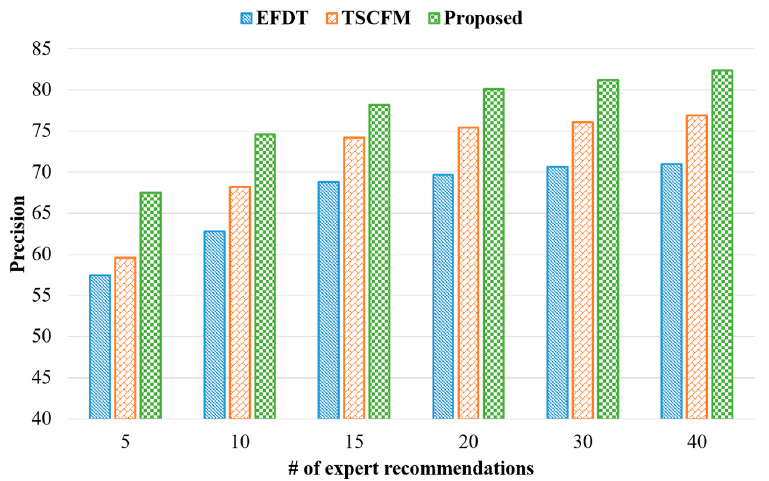
Figure 10. Precision according to the number of expert recommendations.